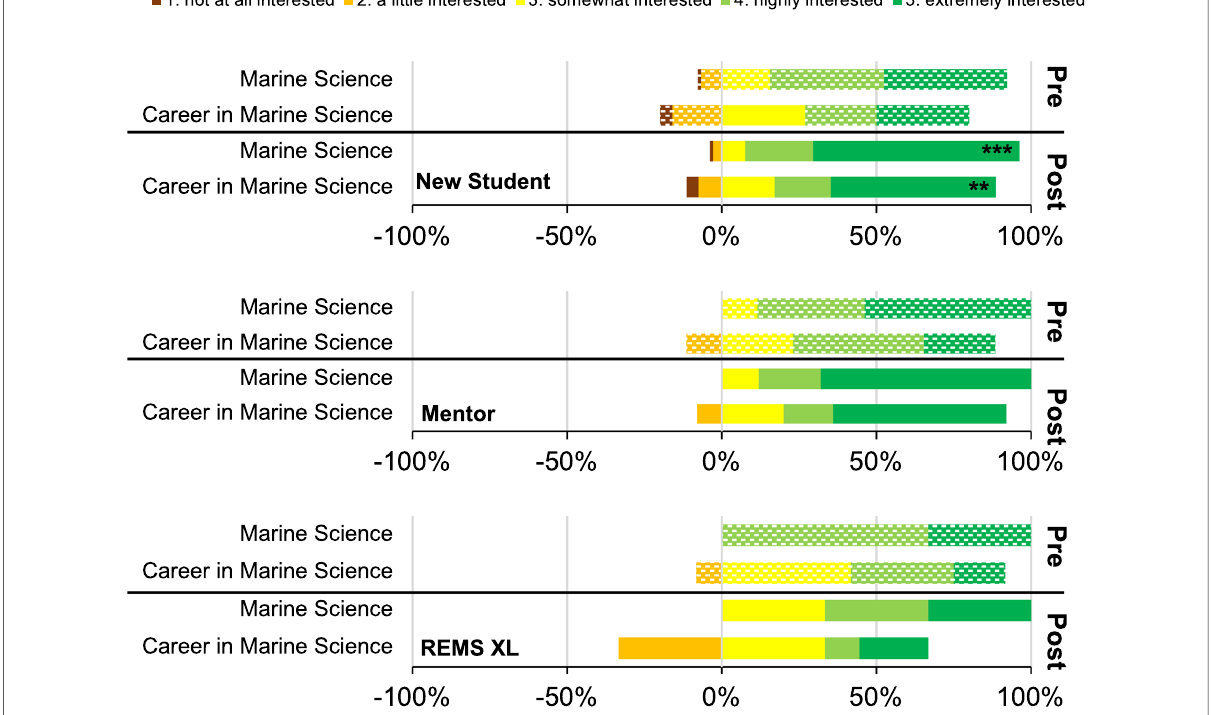
Fig. 15 Interest: Pre- and post-program student interest in marine science. New Student ( N responses to REMS survey items (1 Differences in pre–post scores were analyzed with Mann–Whitney U-tests. ** p < 0.01. *** p < 0.001